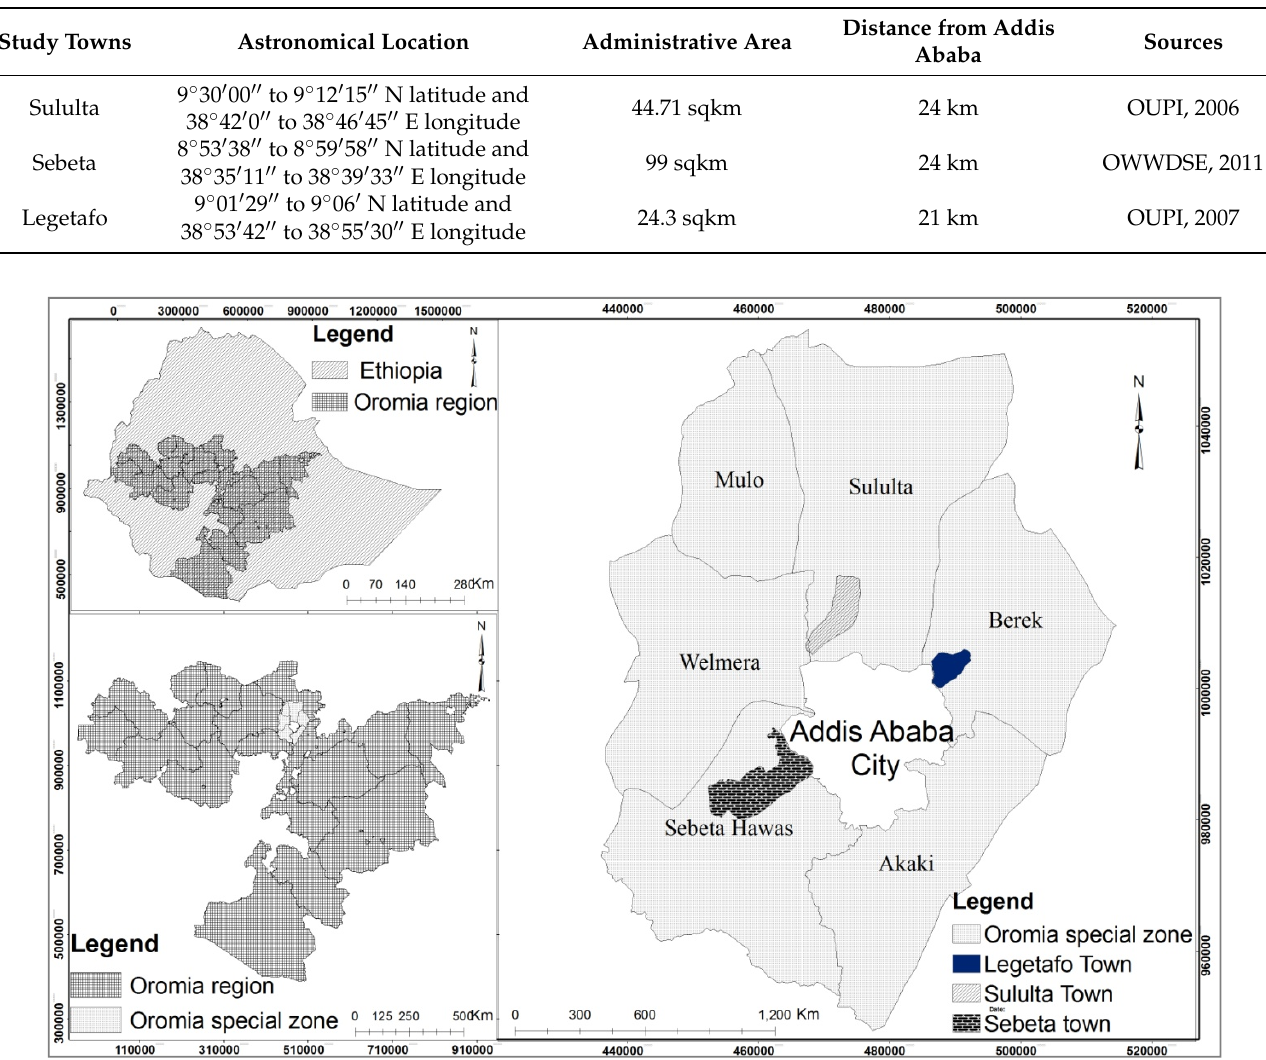
Table 1. Description of the study area.